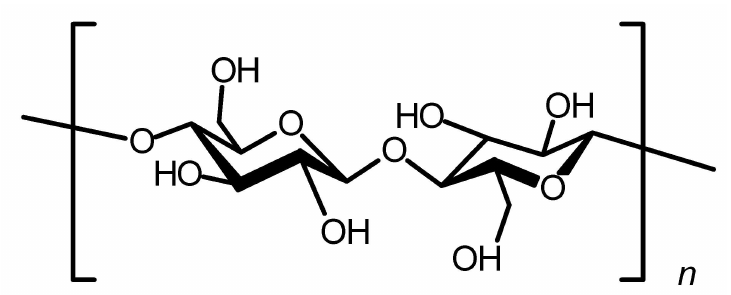
Figure 3. Chemical structure of